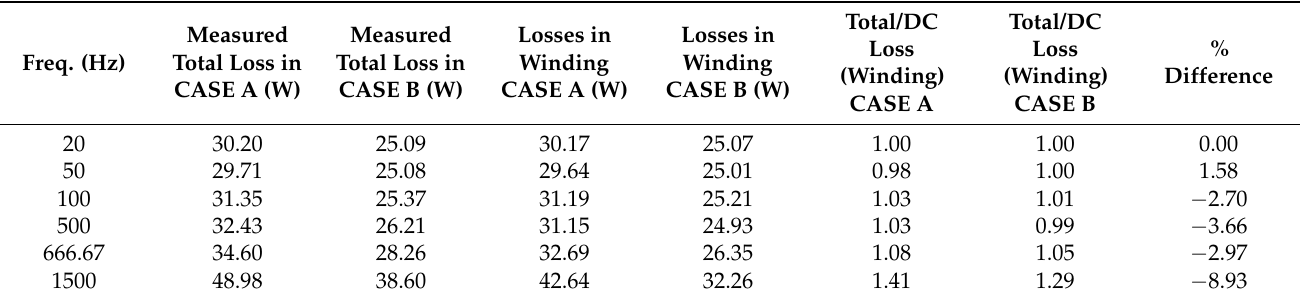
Table 4. Comparison of losses in motorette CASE A and CASE